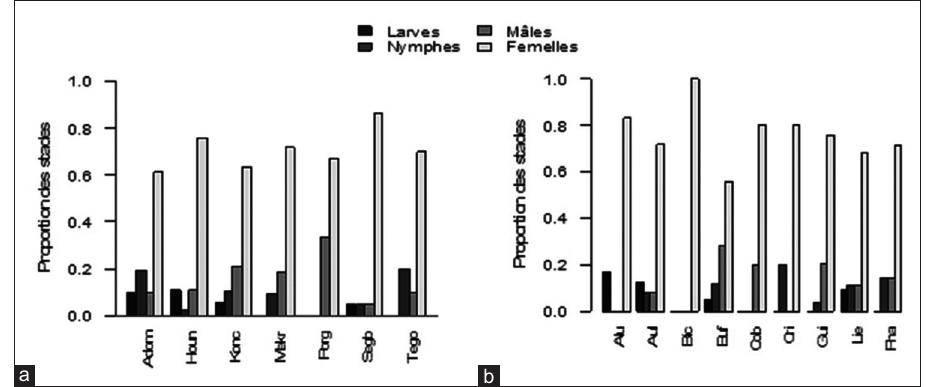
Figure-2: Proportions of the following tick stages (a) localities and (b) animal species. Localities: (Adom=Adomougon, Houn=Hounkpogon, Konc=Koncombri, Mekr=Mekrou, Porg=Porga, Segb=Segbohoue, and Tego=Tegon). Animals: (Alu=Wild cat, Aul=Cane rat, Bic=Doe, Buf=Buffalo, Cob=Buffon cobe, Cri=Cricetoma, Gui=Bushbuck, Lie=Hare, and